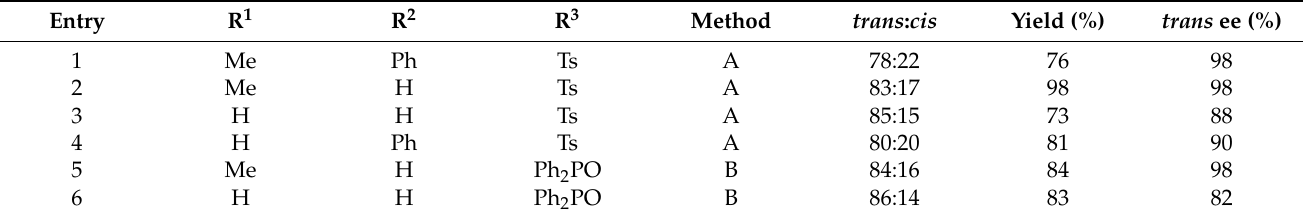
Table 9. Scope of Aggarwal’s chiral allyl sulfonium-mediated aziridination (Scheme 32).